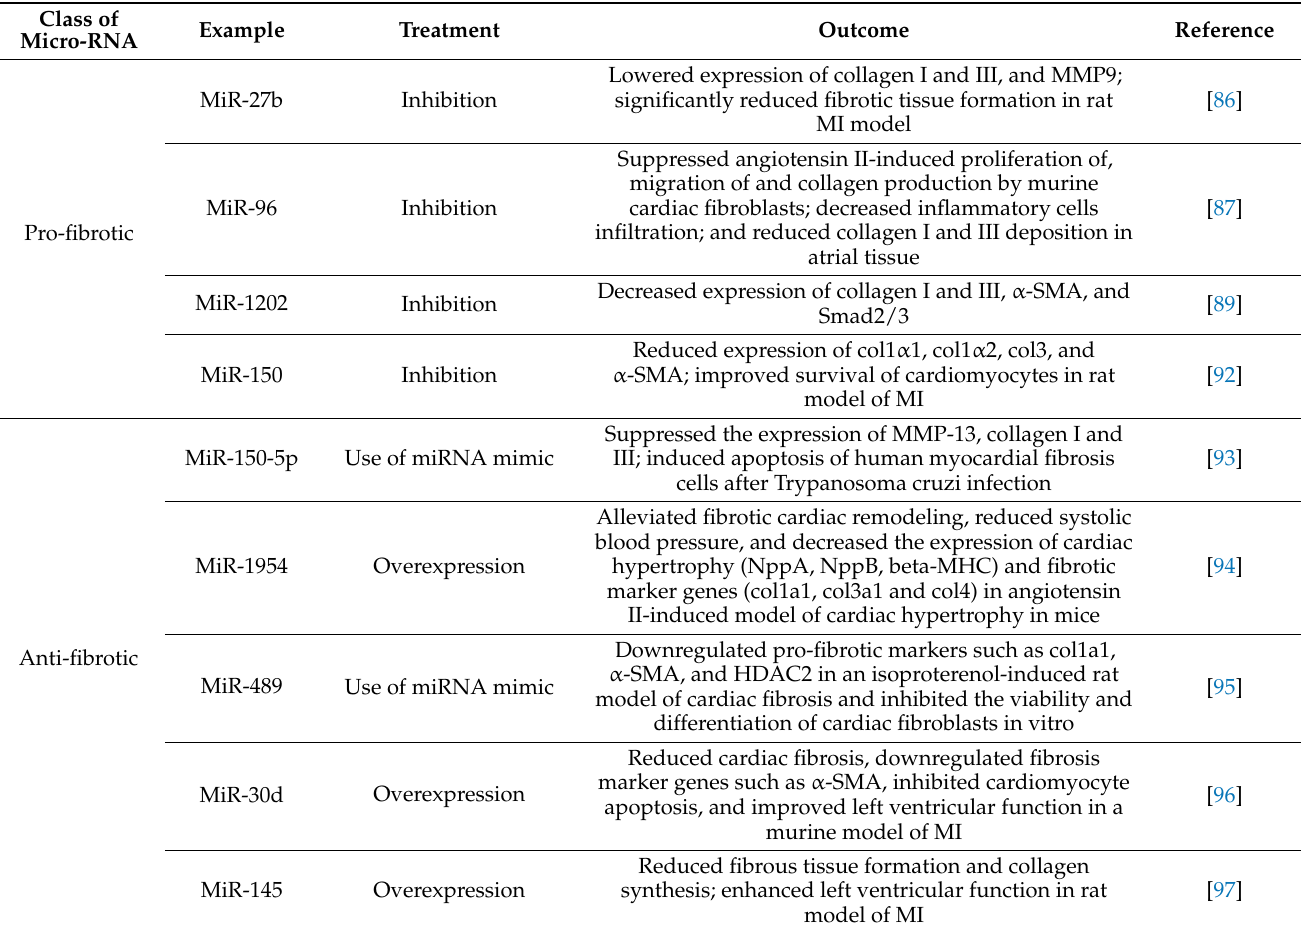
Table 2. The pro- and anti-fibrotic microRNAs used for the treatment of cardiac fibrosis. Class of Micro-RNA